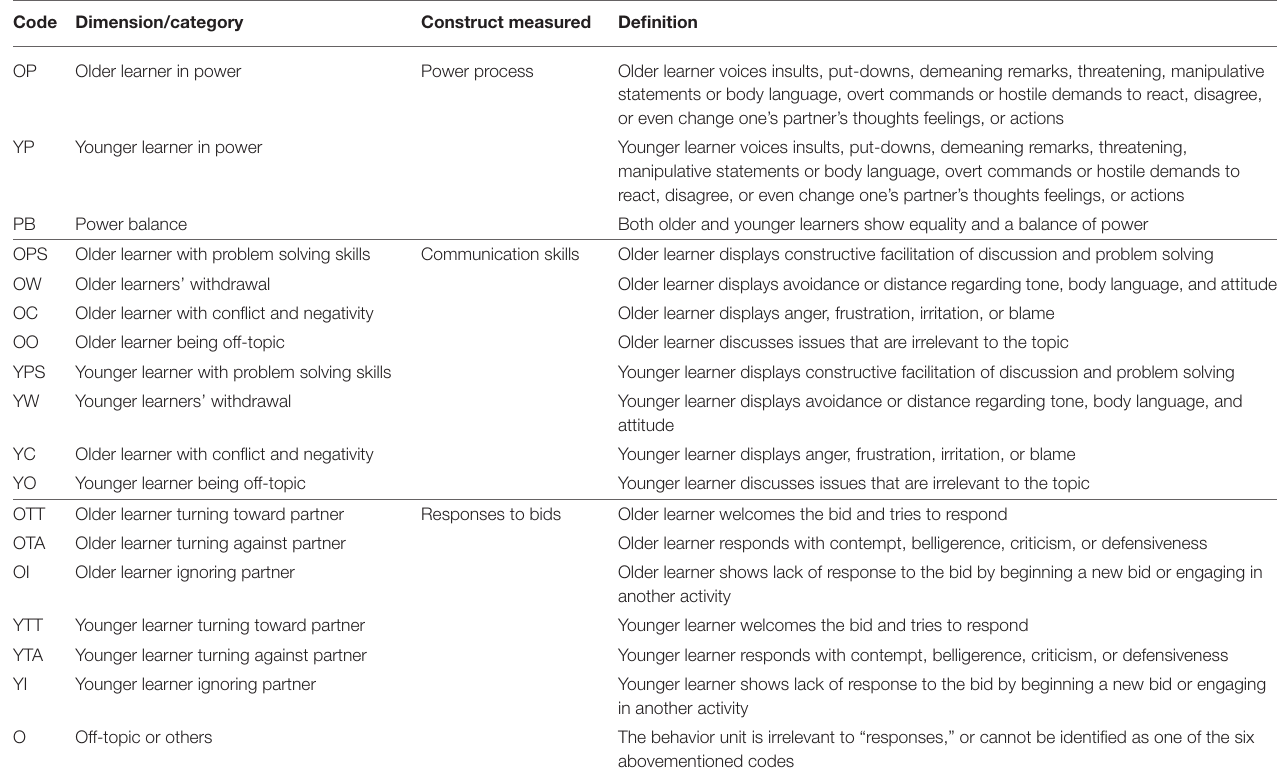
TABLE 2 | Coding scheme for intergenerational learning. Code